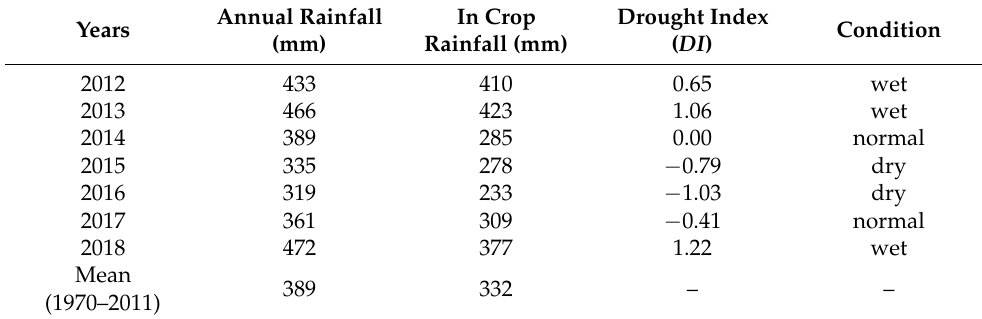
Table 1. Precipitation for the experimental years at the research